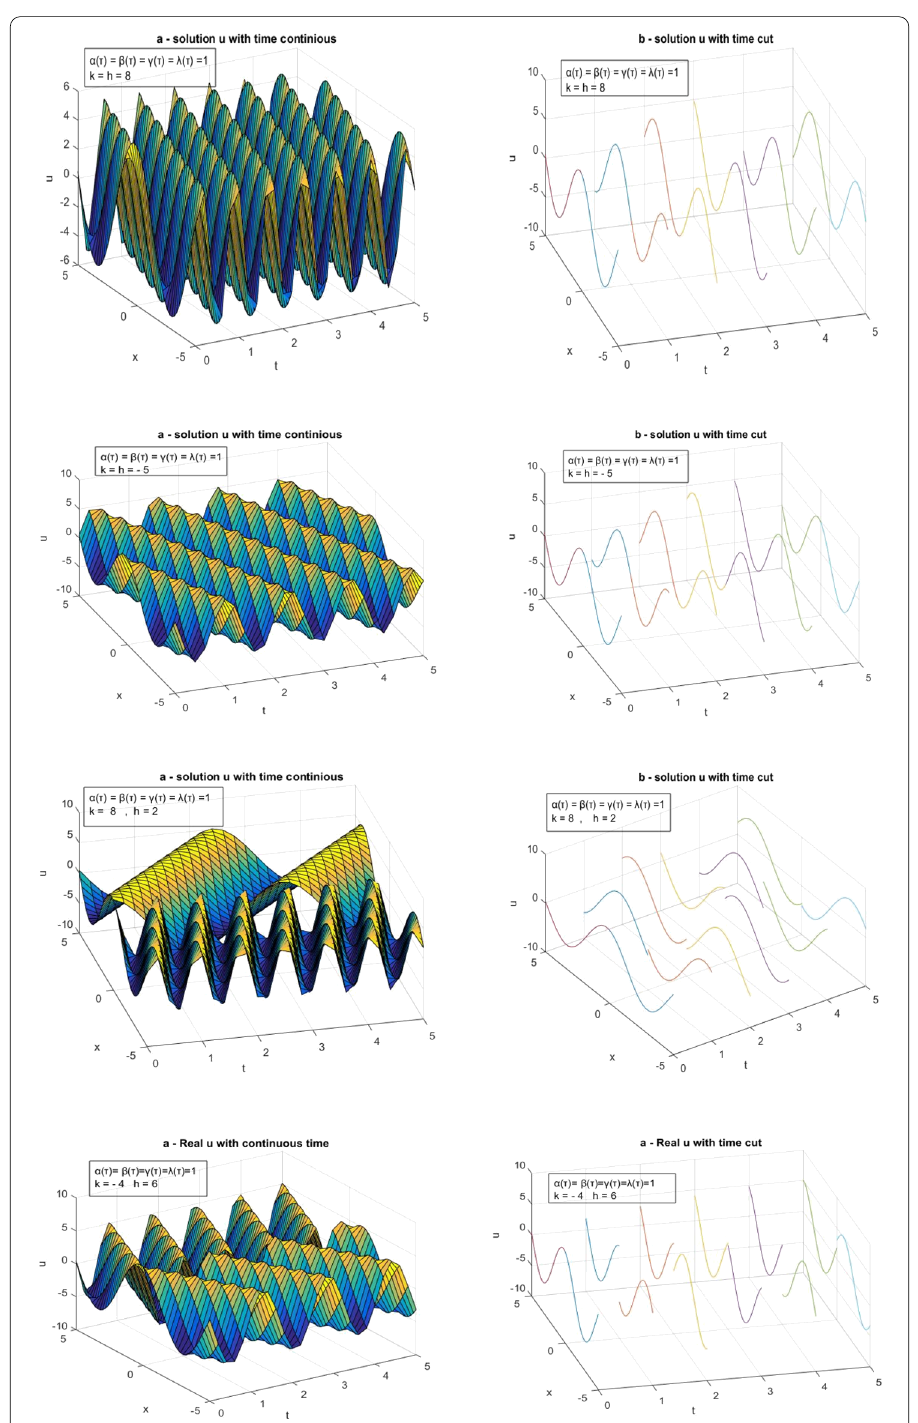
Figure 2 The graph of the solution u in the classic case in Example 1 for different values of k and